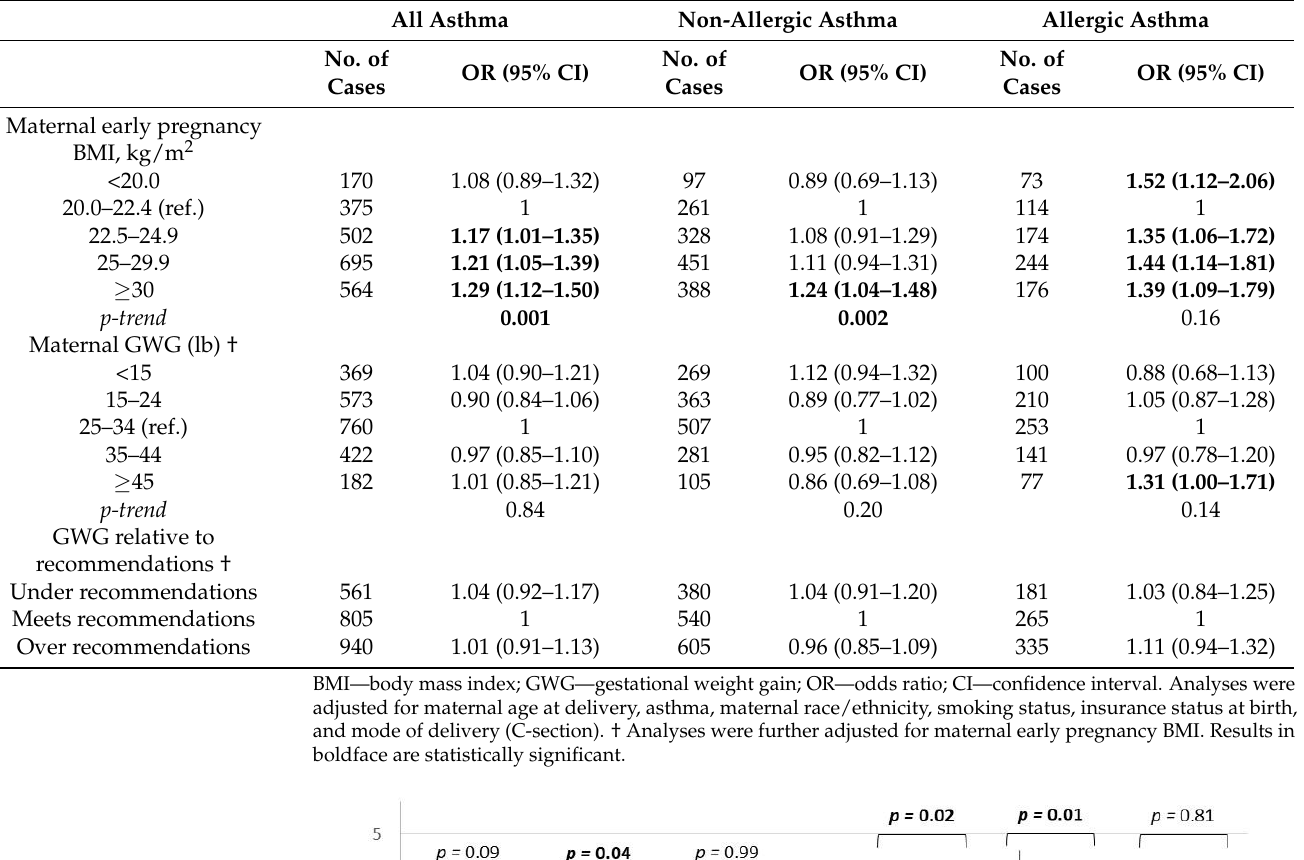
Table 2. Associations of maternal BMI and GWG with incidence of allergic and non-allergic asthma in childhood.